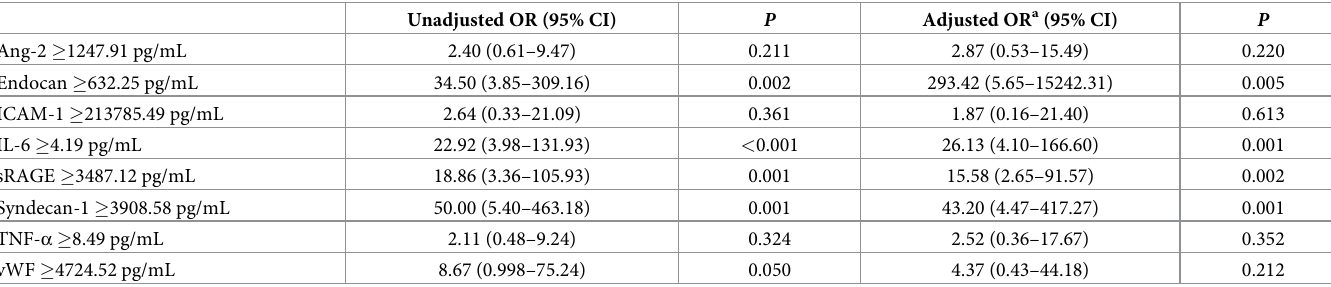
Table 3. Multivariate logistic regression analysis using plasma biomarkers to predict severe COVID-19.